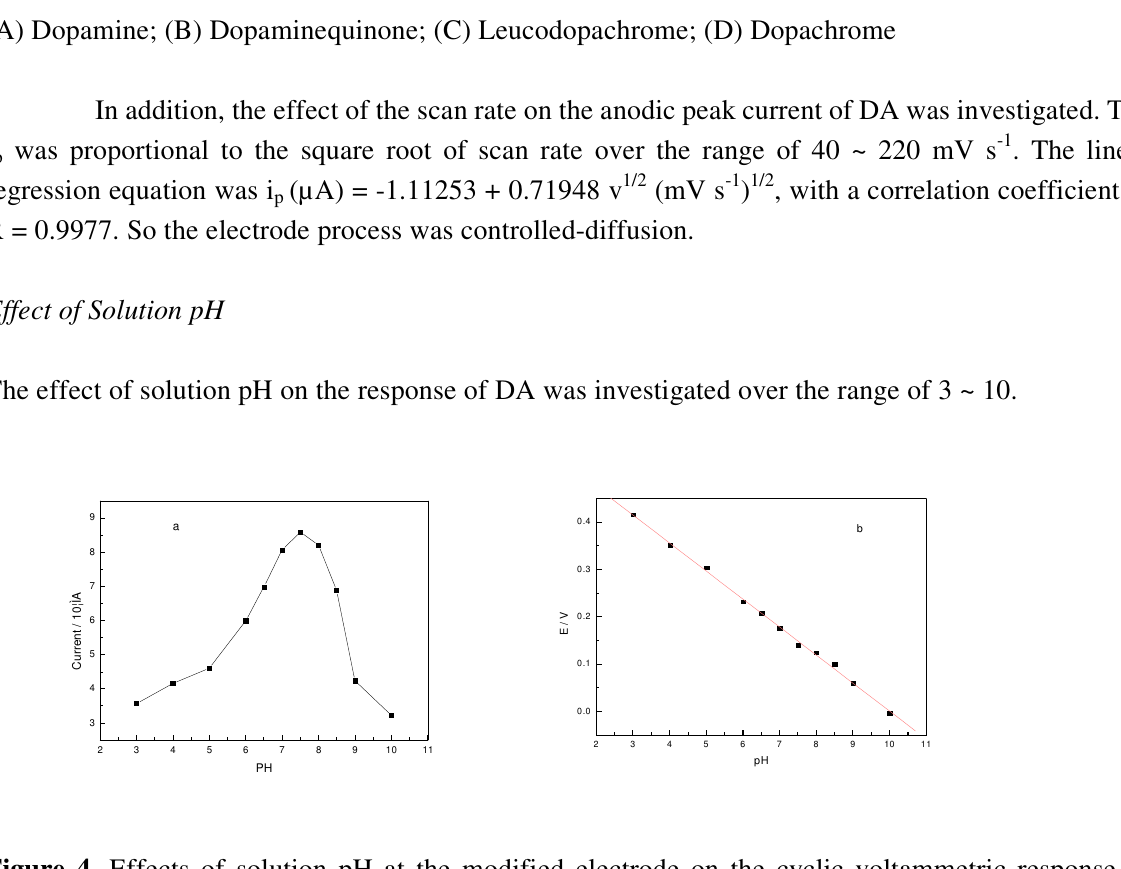
Figure 4 . Effects of solution pH at the modified electrode on the cyclic voltammetric response of 1.0×10 -4 mol/L DA. Sensitivity: 1.0×10 -4 A/V. Scan rate: 100 mV/s. (a)Effects of solution pH on the current. (b) Effects of solution pH on the